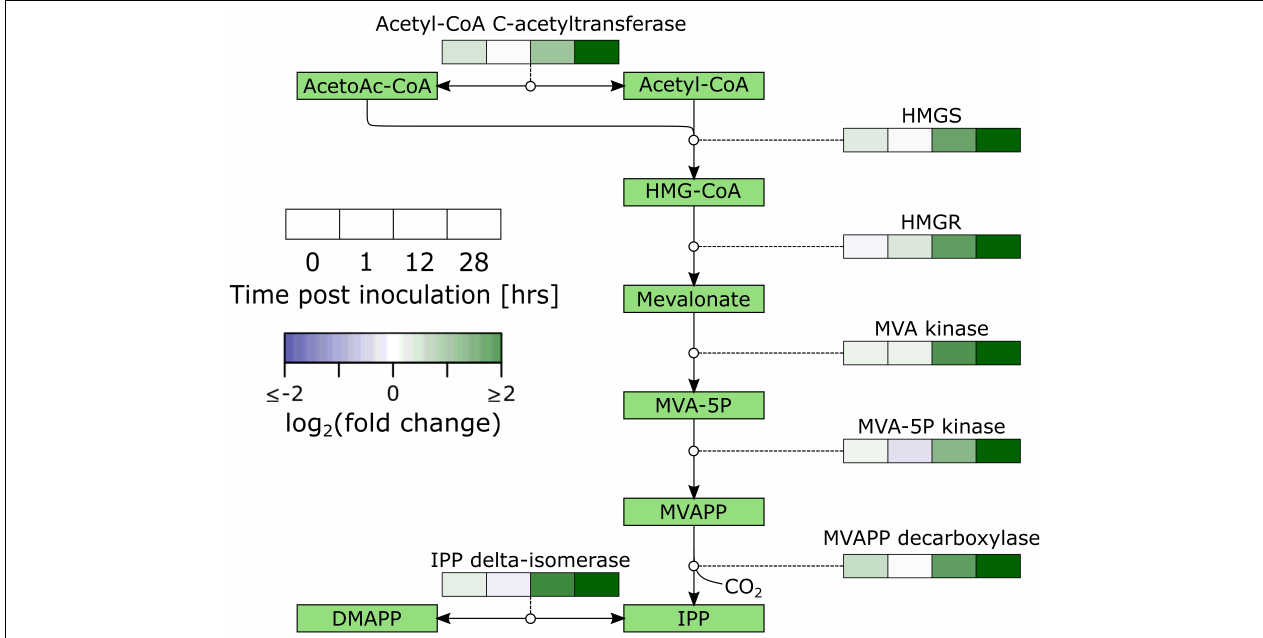
FIGURE 3 | Overview of the regulation of the mevalonate pathway in B. cinerea inoculated apples. Heat maps were constructed from genes with significant differential expression. AcetoAc-CoA, Acetoacetyl-CoA; HMG-CoA, Hydroxymethylglutaryl-CoA; HMGS, HMG-CoA synthase; MVA, Mevalonate; MVAPP,